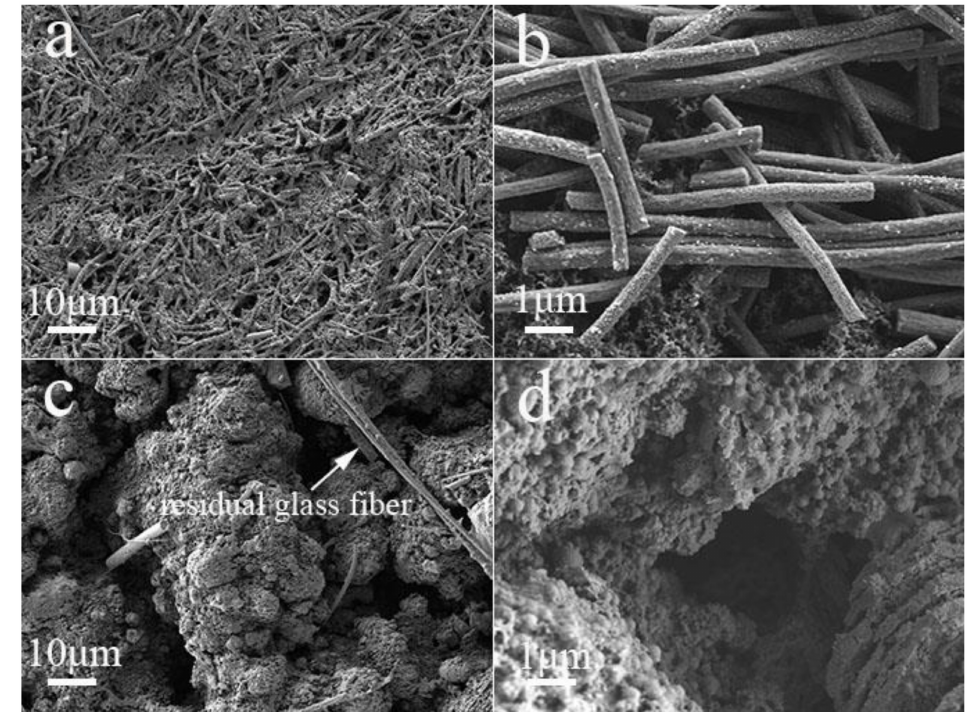
Figure 6. SEM images of ( a , b ) Cu 2 Se-NC and ( c , d ) Cu 2 Se electrode after 100 cycles.